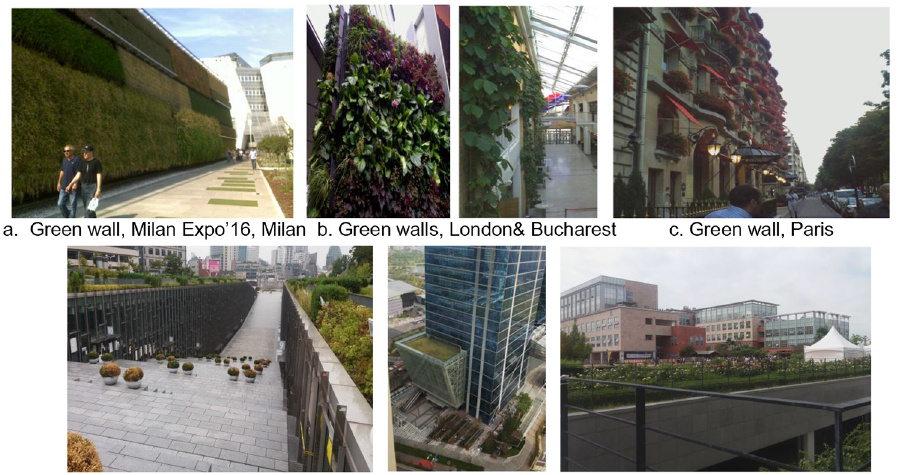
Fig. 3. Various innovative set up of urban green coverage. Photo credits: (Authors 2010, 2015,